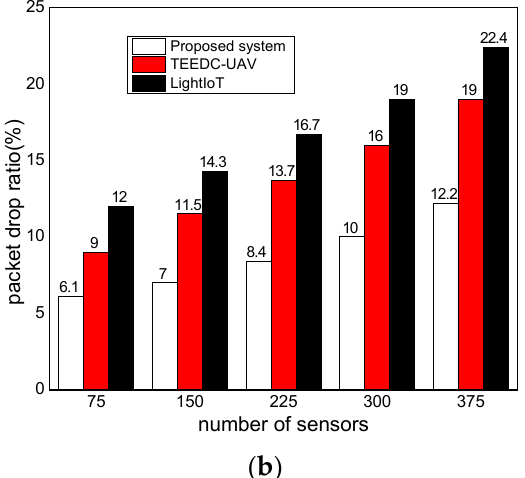
Figure 6. Performance results for varying data sizes and sensors for packet drop ratio. ( a ) Packet drop ratio with varying data size; ( b ) packet drop ratio with varying number of sensors.